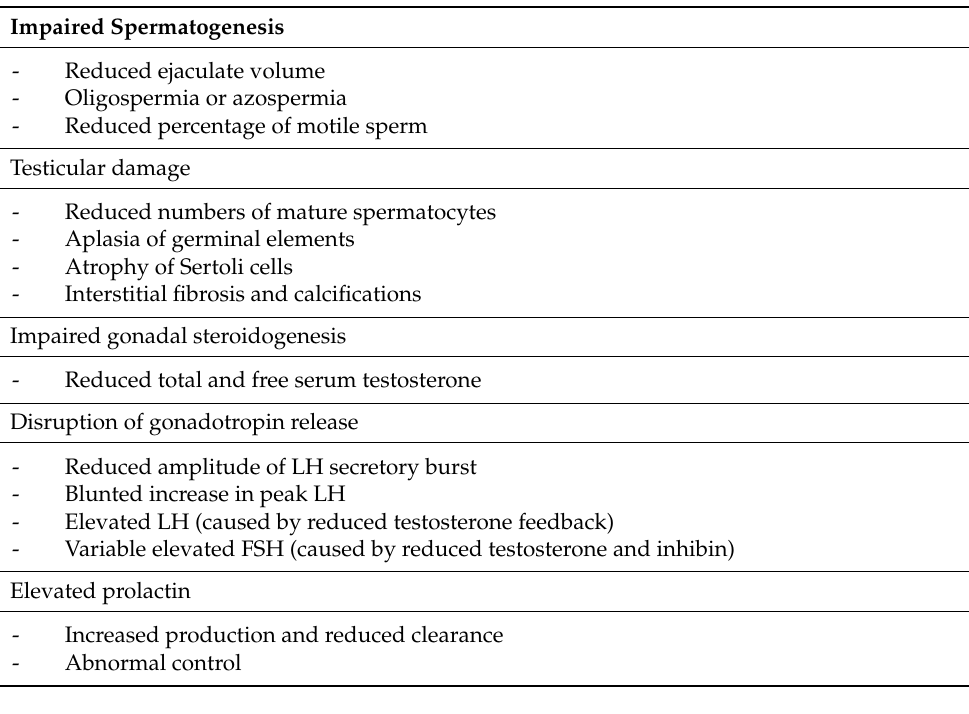
Table 2. Effects of chronic kidney disease (CKD)/end stage kidney disease (ESKD) on hypothalamic- pituitary-testicular